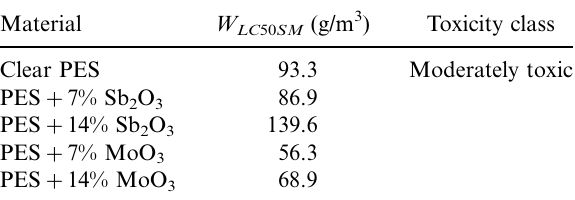
Table 12. Toxicity classification of the thermal decomposi- tion products and combustion of unmodified and modified polyester materials